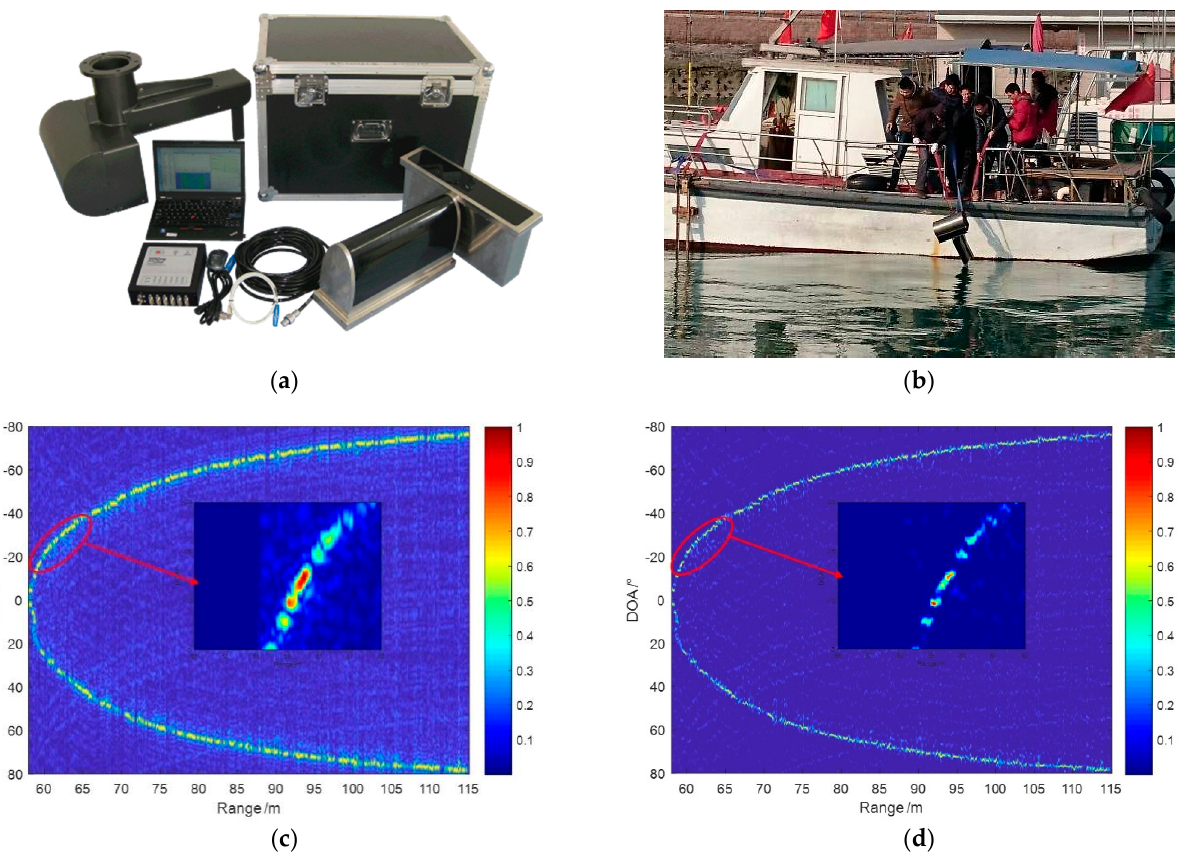
Figure 9. Field experiment carried in Qingdao area with the MBES: ( a ) the horseshoe-shaped MBES equipment; ( b ) MBES installation of the field experiment; ( c ) seabed survey result of CBF; and ( d ) seabed survey result of accelerated deconvolved beamforming.